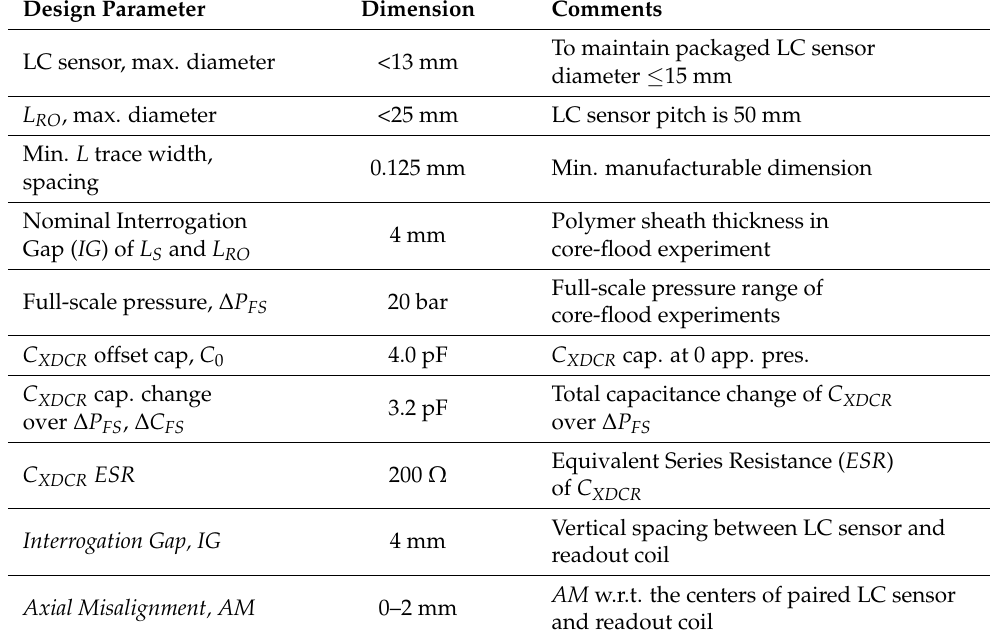
Table 2. Design Constraints for LC Sensor and Readout